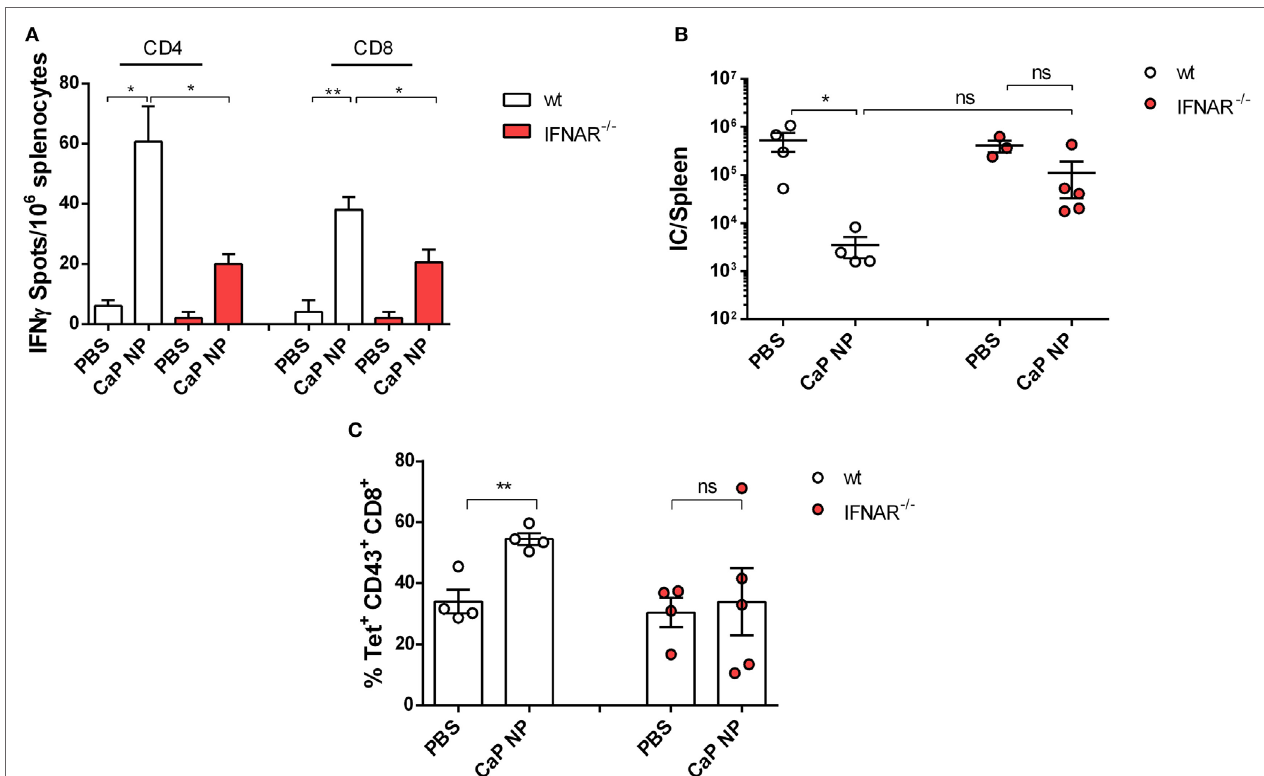
FigUre 3 | Vaccination induced type I interferon signaling is important for sufficient protection against acute FV infection. (a) C57BL/6 mice or IFNAR − / − mice were vaccinated subcutaneously either with phosphate-buffered saline (PBS) or CpG and FV peptide functionalized calcium phosphate (CaP) nanoparticles (NPs) in a prime-boost regiment. 14 days post the last vaccination, mice were sacrificed and splenocytes were restimulated ex vivo with 5 µg/mL of GagL 85–93 or gp70 123–141 peptide. After 24 h, the numbers of IFN- γ -producing CD4 + and CD8 + T cells were determined by using an ELISpot reader. The results of two independent experiments are depicted, n = 6. Statistical analysis was performed by ANOVA with Bonferroni’s multiple comparisons test (* p < 0.05; ** p < 0.01). (B) Vaccinated C57BL6 mice or IFNAR − / − mice were challenged with FV 14 days post the last vaccination. 7 days later, mice were sacrificed and infectious centers (ICs) in the spleen were determined. Statistical analysis was performed by Student’s t -test (* p < 0.05; ** p < 0.01). (c) Frequencies of tetramer + FV-specific CD43 + CD8 + T cells in C57BL6 mice or IFNAR − / − mice 7 days after FV infection. Statistical analysis was performed by Student’s t -test (* p < 0.05; ** p < 0.01). All data represent mean ±